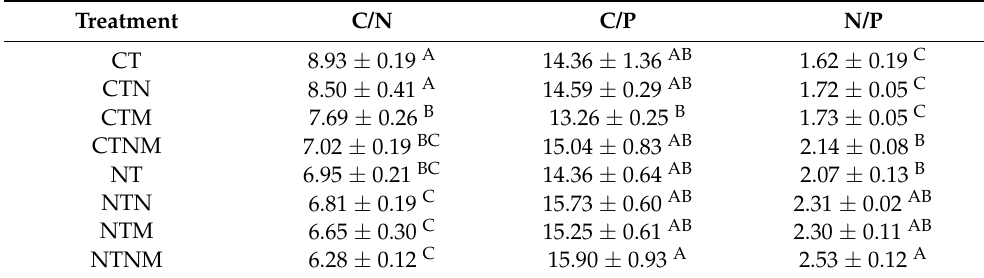
Table 5. Soil stoichiometric ratios under different treatments at 0–10 cm soil